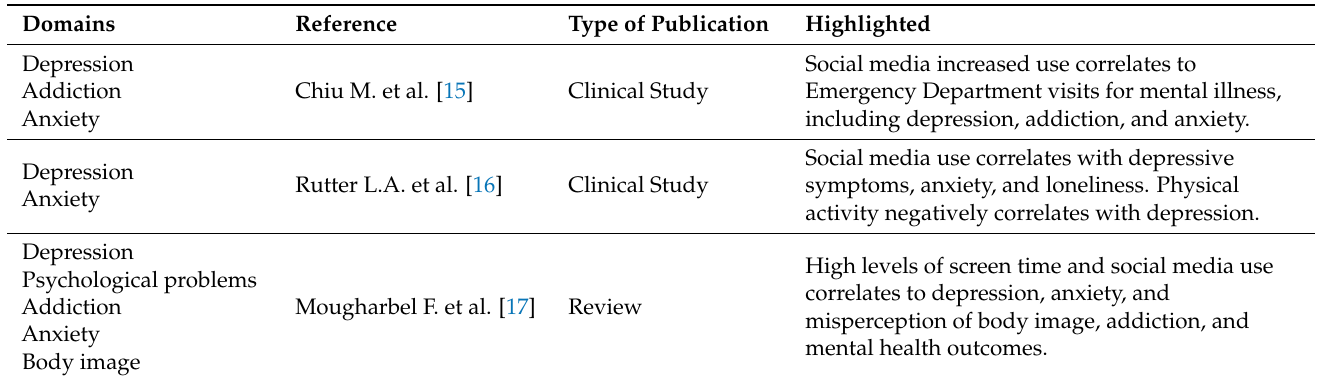
Table 8. Social media and